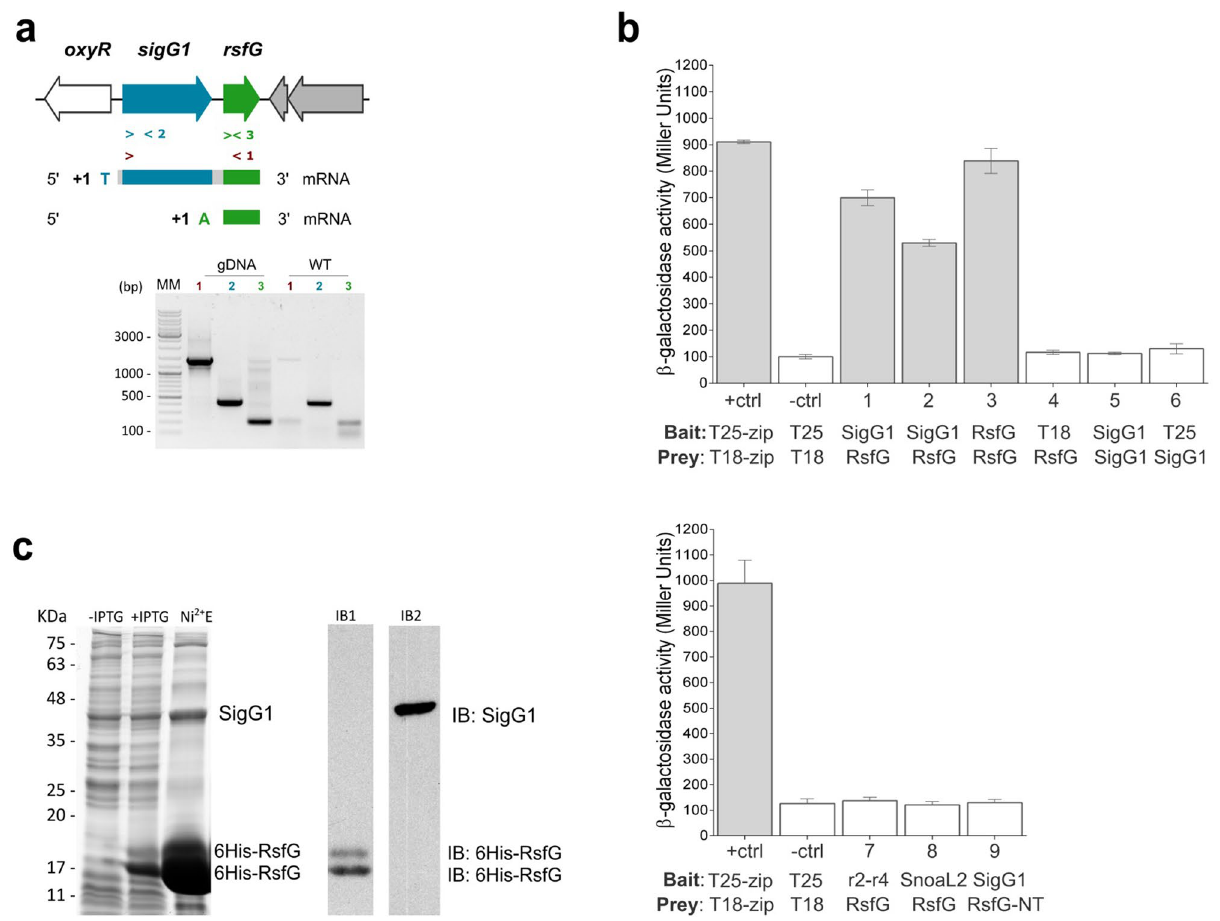
Figure 2. SigG1 interaction with RsfG ( a ) Co-transcription of sigG1 and rsfG (lane 1) was observed by RT-PCR using as template DNase I-treated RNA from the wild-type (WT). Genomic DNA (gDNA) was used as PCR positive control. Transcription start sites (TSS) were mapped by 5 ′ RACE PCR and sequencing. ( b ) BACTH assays for SigG1-RsfG binding in vivo. Positive controls pUT18Czip and pKT25-zip (+ ctrl); Negative control with empty vectors pUT18C and pKT25 (-ctrl); T18-SigG1 and T25-RsfG (1) SigG1-T18 and T25-RsfG (2); T18-RsfG and T25-RsfG (3); pUT18 and T25-RsfG (4); T18-SigG1 and T25-SigG1 (5); pUT18 and T25-SigG1 (6); T25-RsfG and truncated forms of SigG1 – T18-SigG1_r2-r4 region (7), T18-SigG1_SnoaL_2 domain (8); T25-RsfG_N-terminal and T18-SigG1 (9). Results are the average of three independent experiments. Grey bars indicate positive interaction between bait and prey. ( c ) Co-expression and co-purification of SigG1 and RsfG. SigG1 bound to the 6His-RsfG was eluted with 250 mM imidazole (Ni 2+ E). Immunoblot detection using an antibody against the His-tag (IB1) and a polyclonal antibody anti-SigG1 (IB2). Original uncropped images are presented in Supplementary Fig.